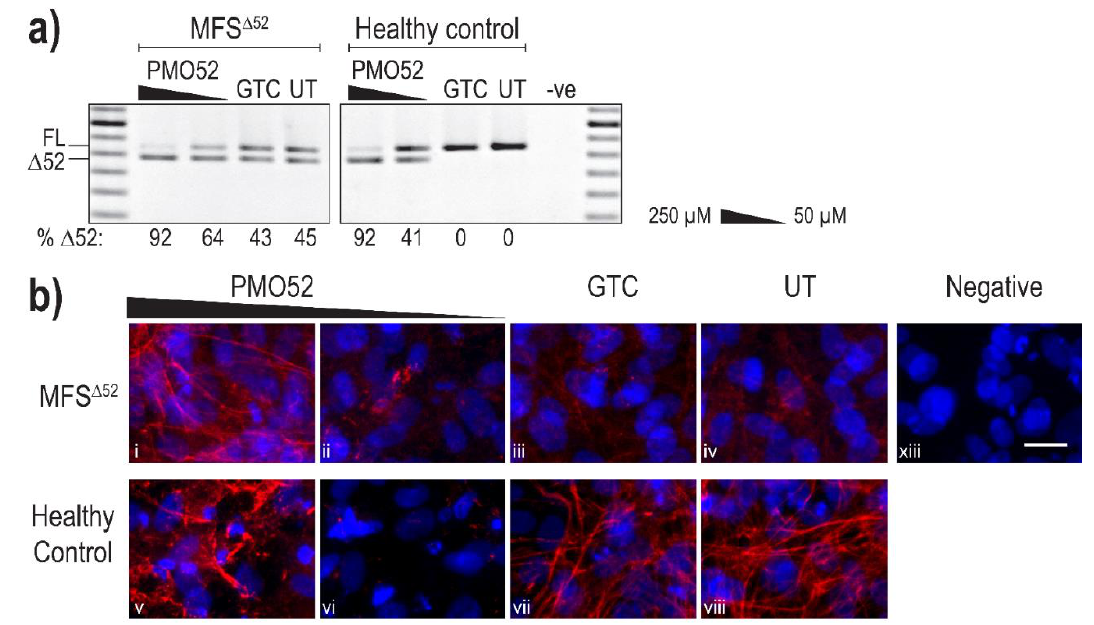
Figure 4. Evaluation of PMO52 in MFS Δ52 fibroblasts. Healthy control and MFS Δ52 patient fibroblasts were transfected with PMO52 (250 μM and 50 μM), GTC or left untreated. Cells were collected 4 days post-transfection. ( a ) RT-PCR analysis of FBN1 exons 47 to 54 amplicons showing full-length (FL, 859 bp) and exon 52-skipped (Δ52, 793 bp) transcripts. The relative abundance (%) of Δ52 amplicons are shown below each gel image. GTC: Gene Tools control PMO, UT: untreated control, -ve: RT-PCR negative control, 100 bp molecular marker used as a size reference. The gels were cropped for presentation. Full gel images are presented in Figure S1 ( b ) Representative images showing fibrillin-1 (red) and nuclei (blue) in MFS Δ52 or healthy control fibroblasts treated with ( i,v ) 250 µM of PMO52, ( ii,vi ) 50 µM of PMO52, ( iii,vii ) 250 µM of GTC or ( iv,viii ) left untreated. ( xiii ) negative control with no primary antibody added. Scale bar = 20 µm. The images were cropped for presentation. Full images are presented in Figure S3.